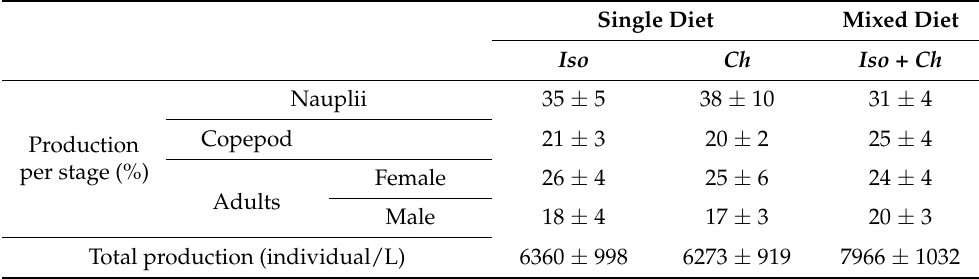
Table 2. Population growth of Oithona nana fed with single and mixed diets after 16 days in culture. The percentage of the population as nauplii, copepodites, and females and males are recorded, as well as the total population size (ind./L) by day 16. Values shown as average ± standard.